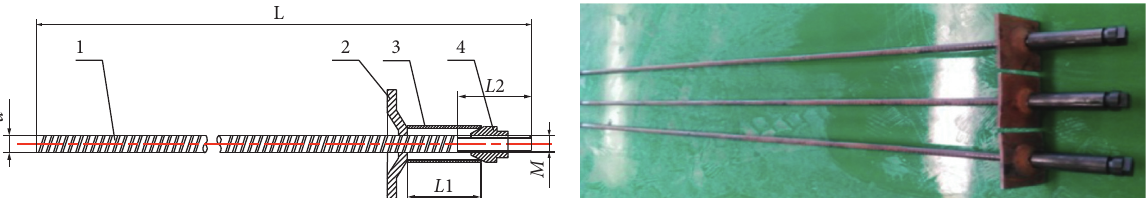
Figure 1: Energy-absorbing anti-impact anchor.